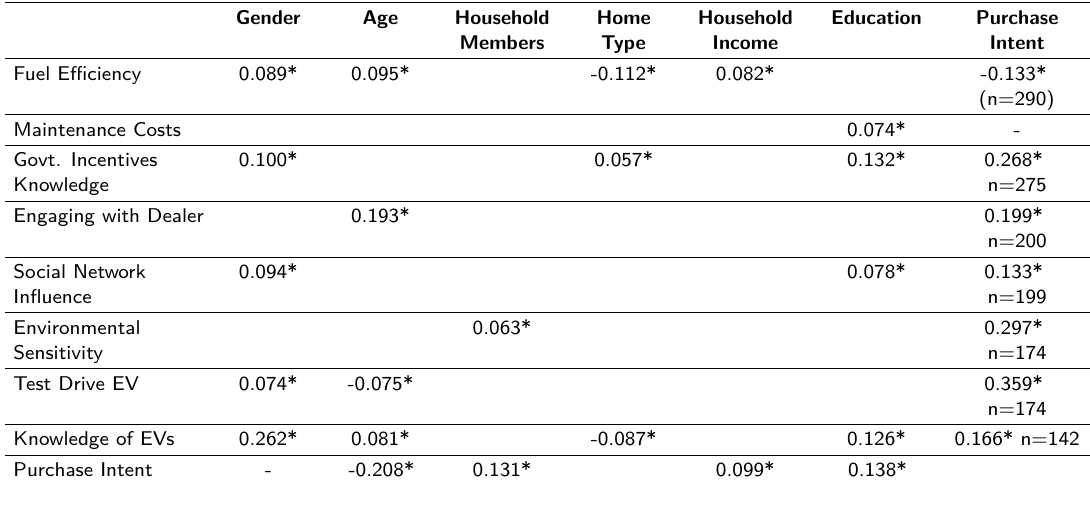
Table 4 . Statistically significant correlations between descriptive and inferential